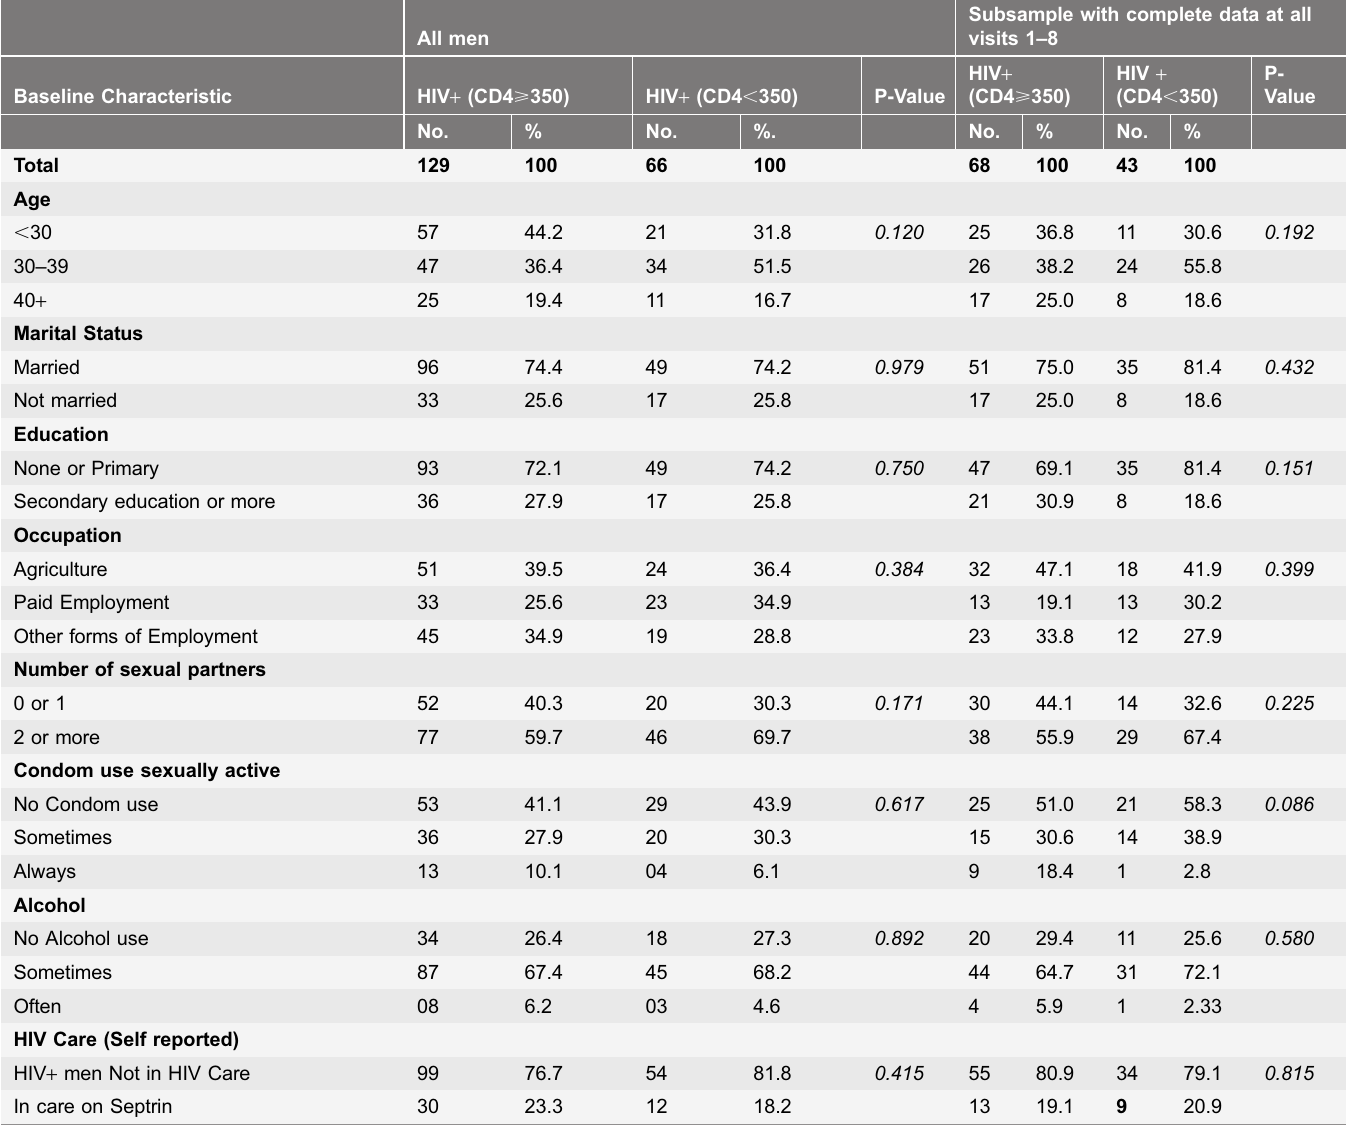
Table 1. Baseline characteristics by CD4 group for the main and the sensitivity analysis